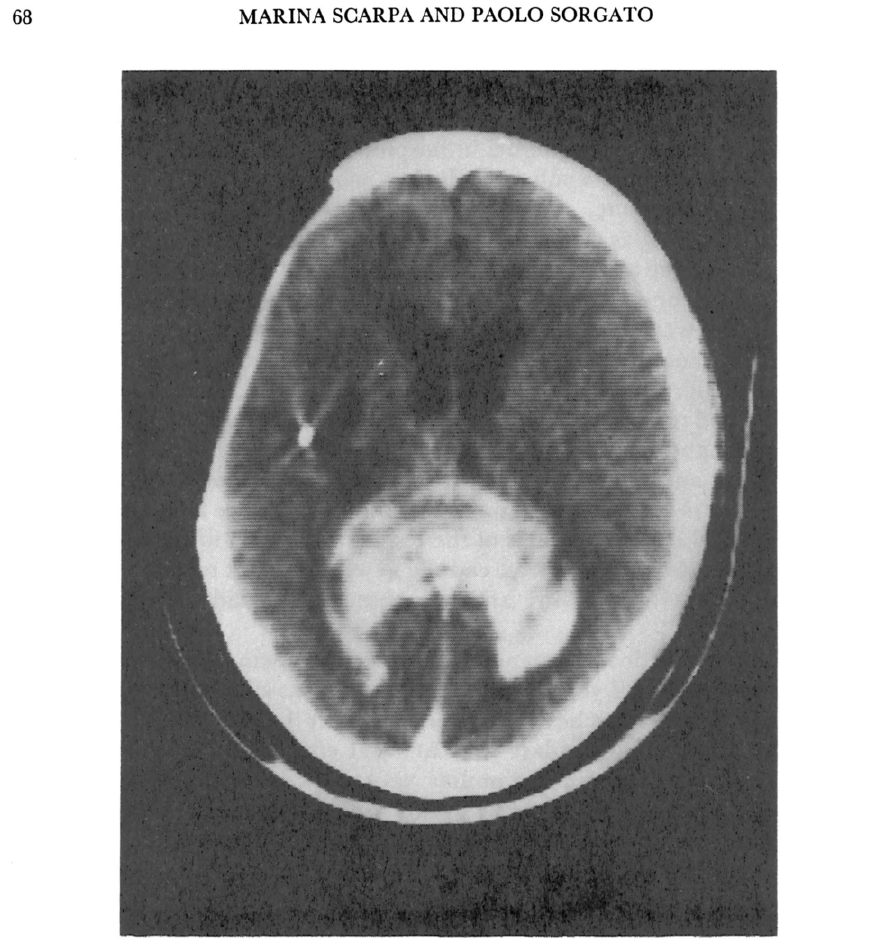
FIG. 1. Butterfly glioma of the splenium of the corpus callosum. On the right, radiological sequelae of the surgical removal of the frontoparietal polar spongioblastoma in 1976 (enhanced CT -scan axial